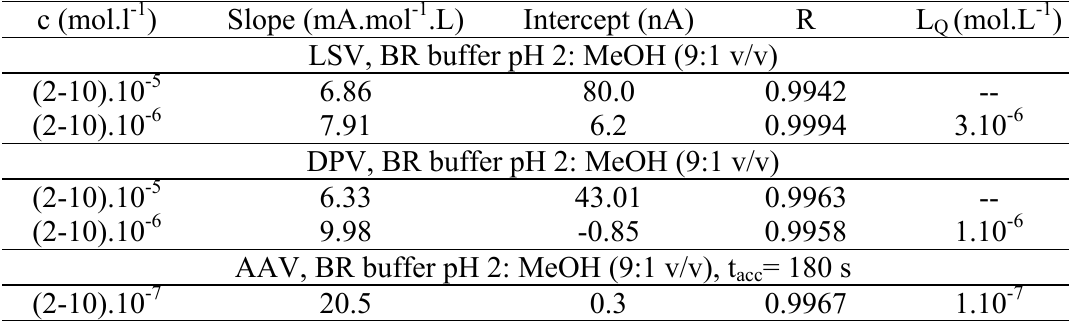
Table 1. Calibration data for voltammetric determination of 1-AP at GCPE in a BR buffer : MeOH mixture.